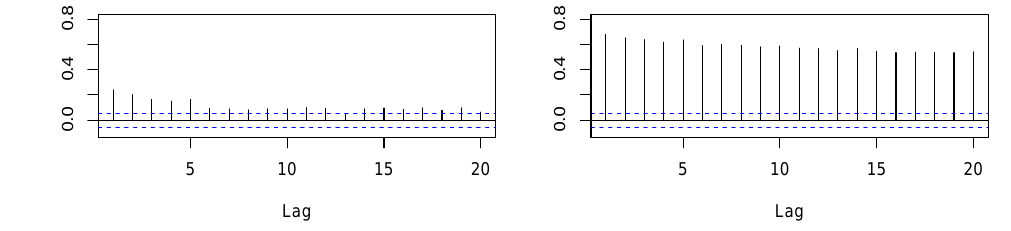
Figure 1. In-sample: autocorrelation functions of (cid:98) L t ( left ) and (cid:98) w t ( right ).